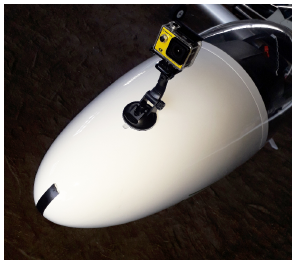
Figure 17. Glider bow with mounted camera used in experiments.